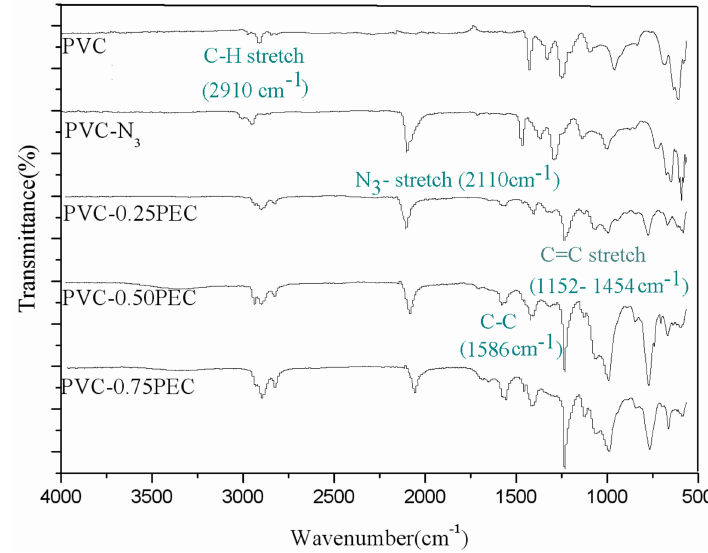
Figure 2. FT-IR spectra of PVC and internally plasticized PVC